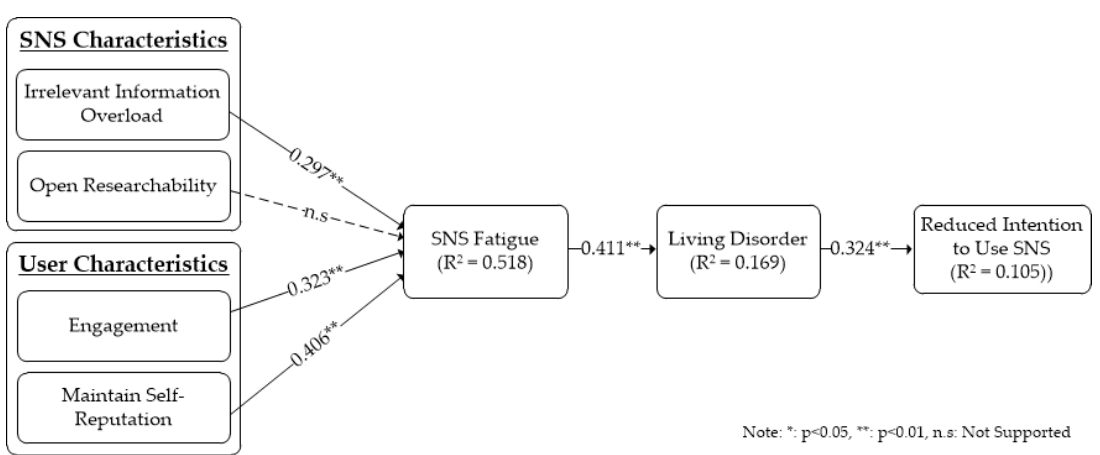
Figure 3. The structural model for the direct effects (H1 to H6). Table 8. Summary of hypothesis tests (H1 to H6).